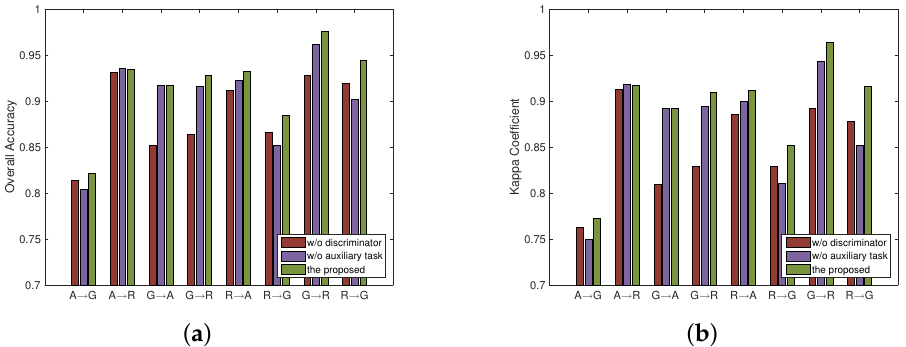
Figure 15. Comparison results of the ablation study. ( a ) Results of OA. ( b ) Results of